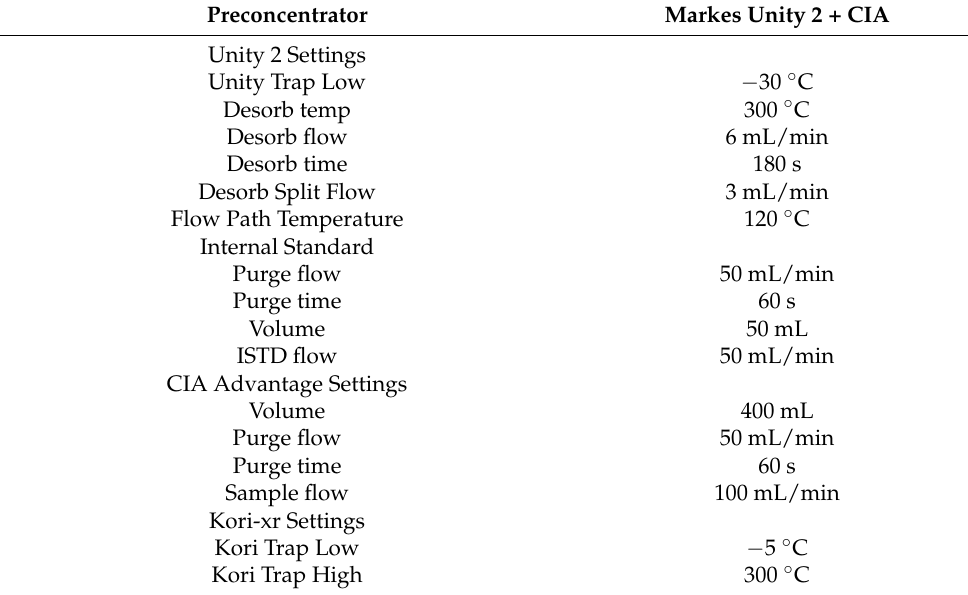
Table 1. Preconcentrator settings.